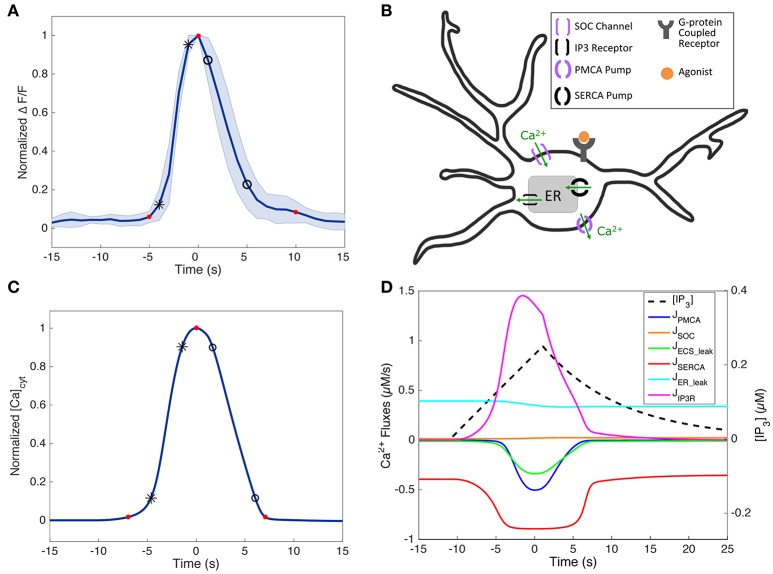
Short-duration SP Ca2+ traces in experiments and the model. (A) Normalized average short-duration (< 25 s) SP Ca2+ traces of the soma (N = 8, mean ± standard deviation, stimulus durations 16–250 ms). The response amplitude and latency were ignored by normalizing the amplitudes and aligning the response peaks. (B) Simplified schematic of an astrocyte and its major Ca2+ components incorporated in the model (except for GPCR dynamics, which is replaced with IP3 as the input). Additionally, leak terms between the cytosol and extracellular space (JECS_add) and between the cytosol and the ER (JER_leak) are included in the model. Arrows show the direction of Ca2+ flux. The model has only one compartment, tuned to represent data from different astrocyte subcompartments (see section Variability between Astrocyte Subcompartments: Model). (C) Normalized SP response in the model, fitted to match the experimental trace in (A). IP3 parameters (A, drise, rrise, ddec): 0.25, 12, 0.002, 40. The experimental and model Ca2+ rise times (calculated between the black star markers), decay times (between the black circles), and durations (between the first and last red circles) are as follows: 2.90, 3.90, and 14.7 s (for experiments), and 3.19, 4.38, and 14.05 s (for the model). (D) Simulated IP3 dynamics and Ca2+ fluxes corresponding to (C).